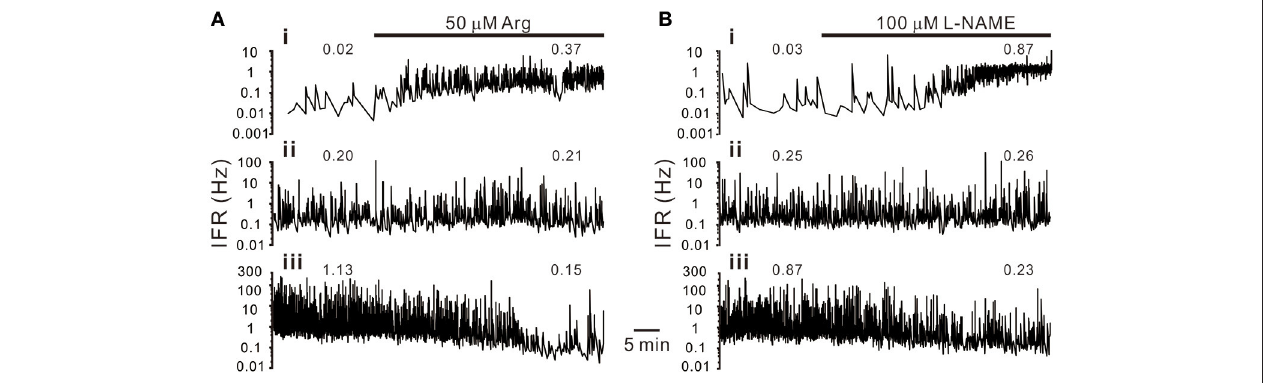
FIGURE 2 | Heterogeneity in sympathetic firing responses elicited by bath applications of L-arginine (Arg, an NO precursor; A ) or L-NAME (an NOS inhibitor; B ). Traces show the time course of the splanchnic sympathetic single-fiber activities. IFR, instantaneous firing rates. Numerical values on top of traces are average firing rates (AFR). Traces i–iii show firing increased, not apparently changed or decreased. Examples show apparent differences in their basal activity levels under control conditions. Firing activities in the fibers of low basal activity were increased, and in those of high basal activity decreased, by either enhancement or diminution of NO